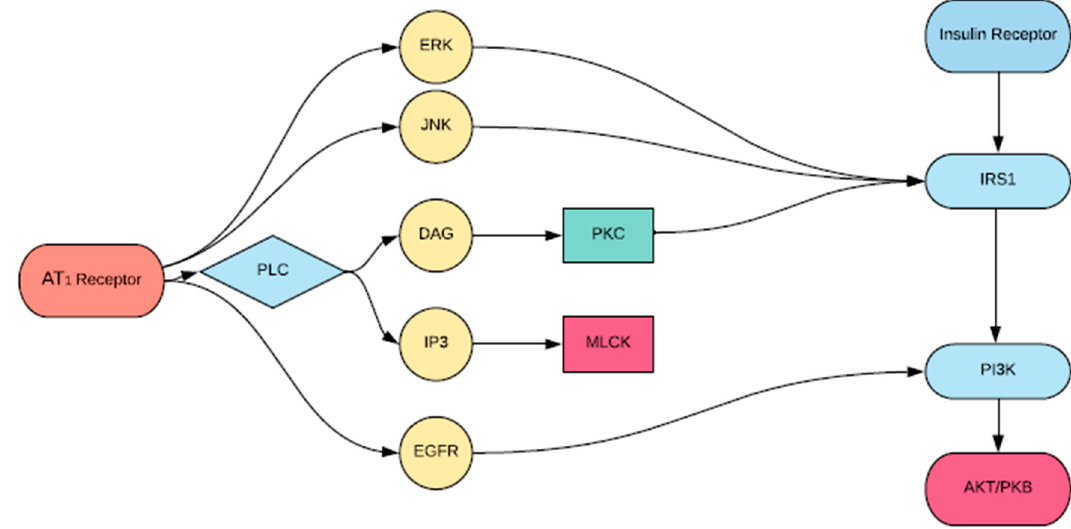
Figure 3. Proposed scheme of angiotensin (ANG) II-induced inhibition of protein kinase B (AKT) activation by insulin. Vascular agonist ANG II activates protein kinase C (PKC), which inhibits phosphorylation of insulin receptor substrate 1 (IRS1), phosphoinositide 3 kinase (PI3K) activation, and AKT activation.